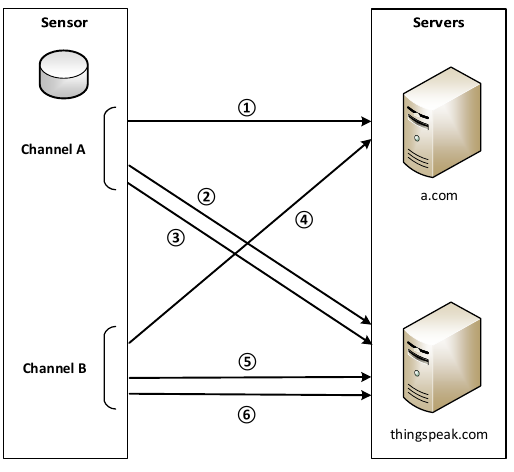
Figure 5. Communication Protocol between an a.com Sensor and